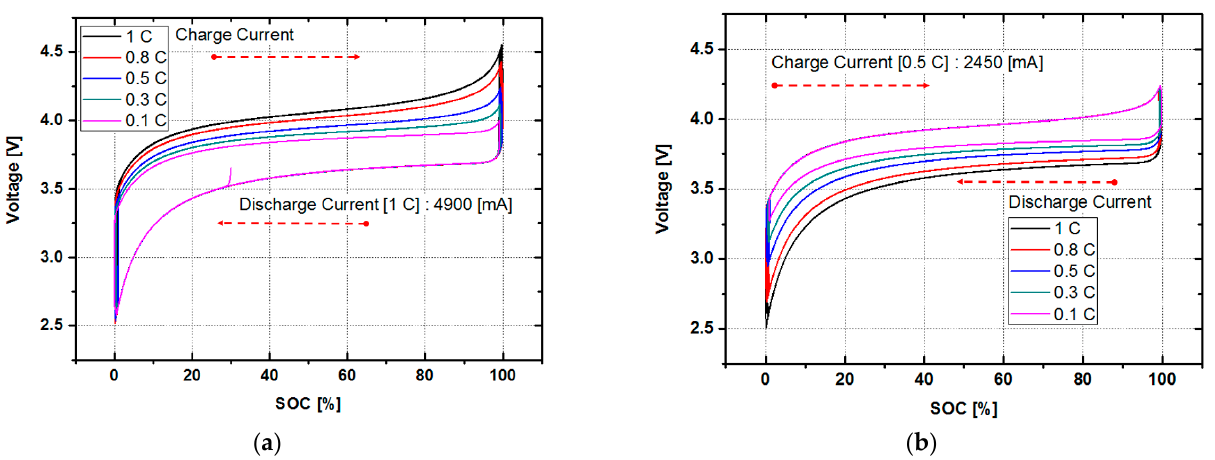
Figure 3. The voltage curves for SOC using different currents: ( a ) voltage against SOC when charging with different currents. The result using a fixed discharge current of 1 C is also shown and ( b ) voltage against SOC when discharging at different currents. The result using a fixed charge current of 0.5 C is also shown.